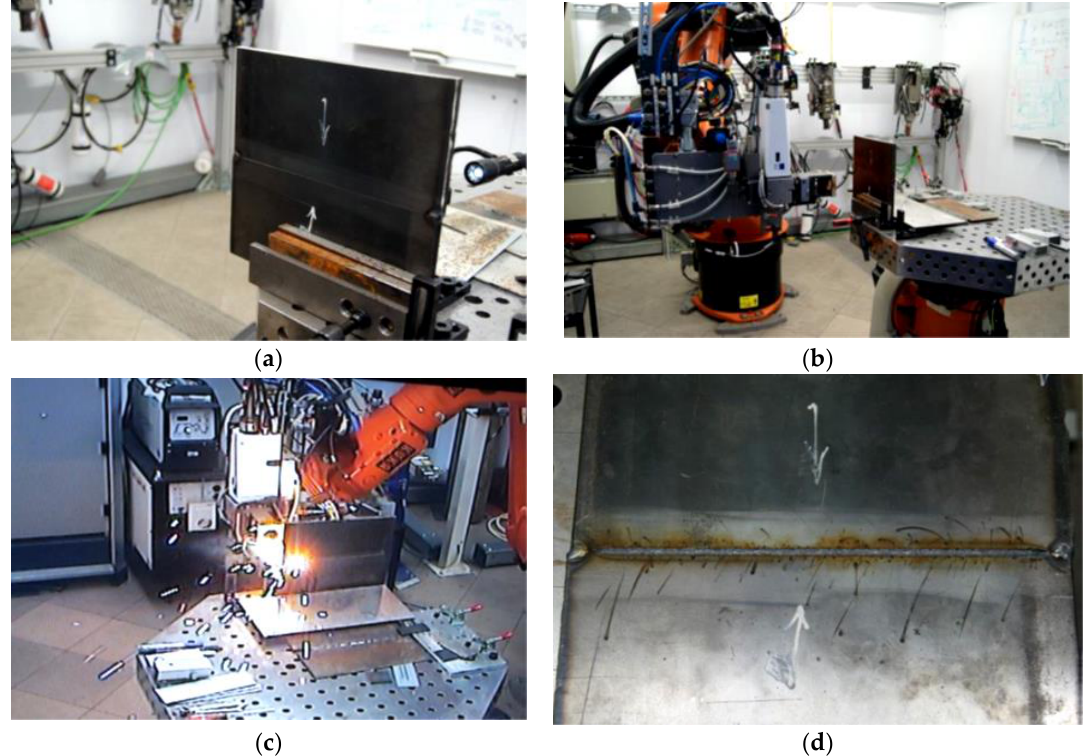
Figure 5. Laser welding of the joint in the PC position with 5 kJ/cm linear energy: ( a ) tacked plates fixed vertically, ( b ) determination of the weld axis, ( c ) course of the welding process, and ( d )finished joint.